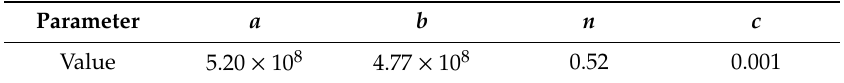
Table 4. Parameters for simplified Johnson-Cook model for 7075-T651 aluminum plate.